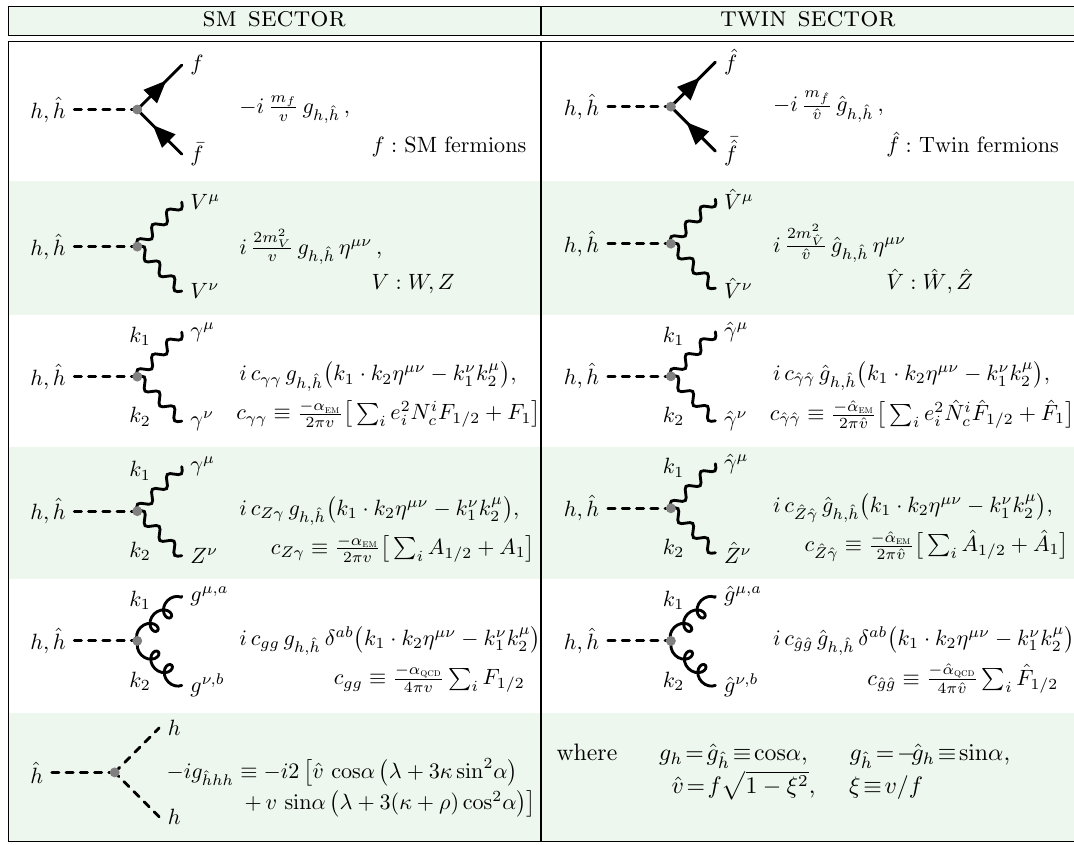
Figure 16 . Feynman rules for the interactions of SM and twin sector particles with the SM Higgs h and heavy twin Higgs ^ h . The SM triangle loop functions F and the corresponding twin triangle loop functions ^ F SM ones but with twin particles in the